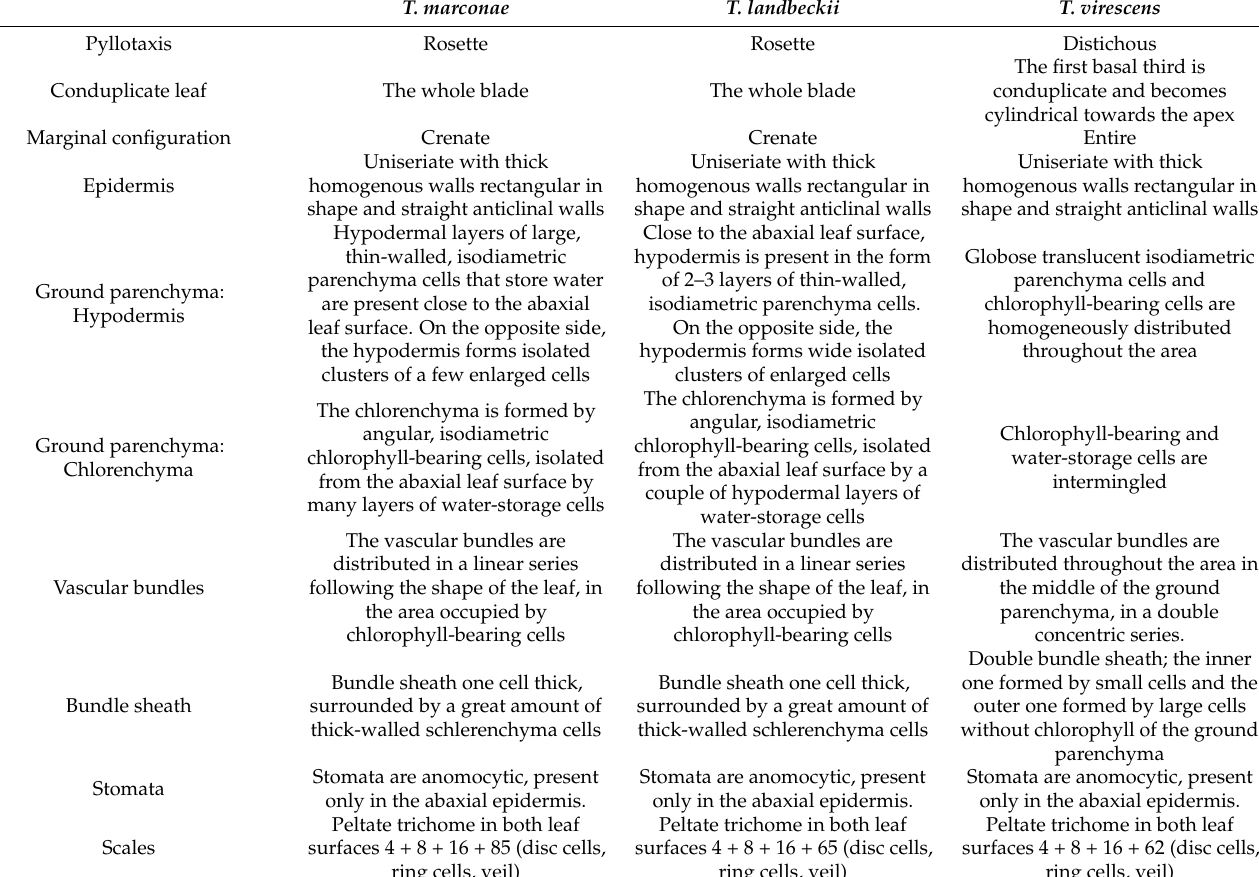
Table 2. Anatomic comparison between Tillandsia marconae , T. landbeckii, and T. virescens . T.